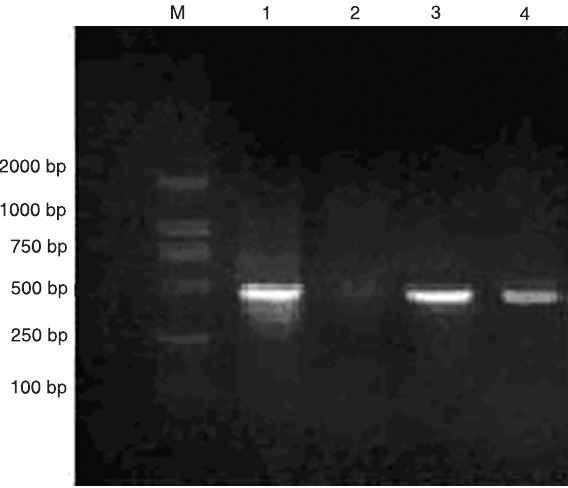
Figure 5. Expression of TRAIL mRNA receptors in MCF-7 cells. Lane M , DL2000; lane 1 , DcR2 (453 bp); lane 2 , DcR1; lane 3 , DR5 (502 bp); lane 4 , DR4 (506 bp). TRAIL = tumor necrosis factor-related apoptosis-inducing